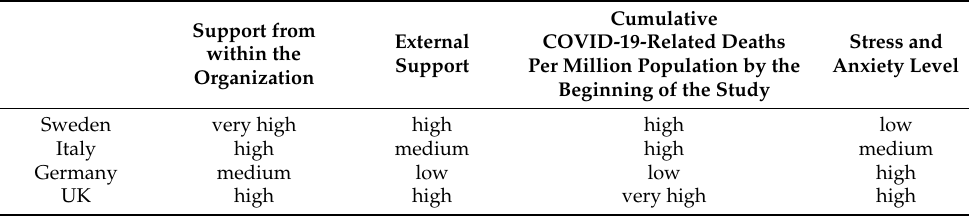
Table 6. Comparison of factors affecting stress level across